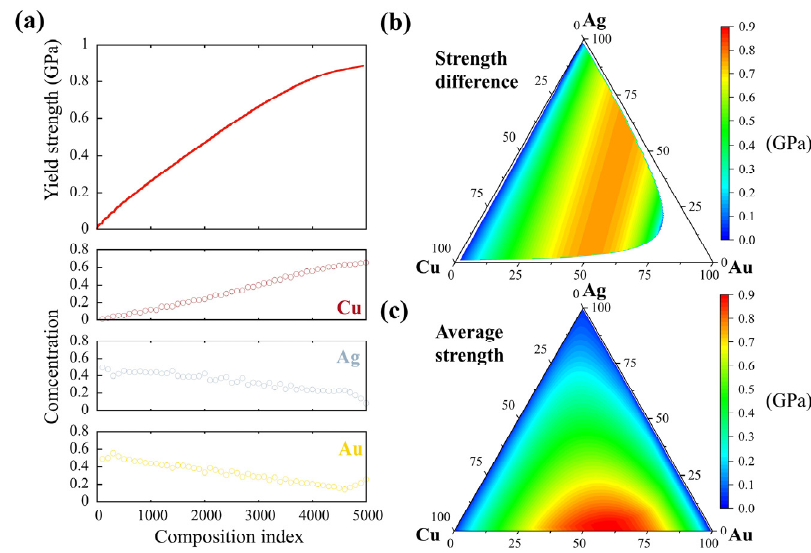
Figure 10. The first-principles-based prediction of yield strength in the full composition space. ( a ) The dependence of yield strength on alloying concentration in disordered FCC phase. ( b ) The strength difference between the Ag-rich and Cu-rich phases in the two-phase region. ( c ) The average yield strength in the ternary Au-Ag-Cu alloy according to the rule of mixtures. The compositions are in wt.